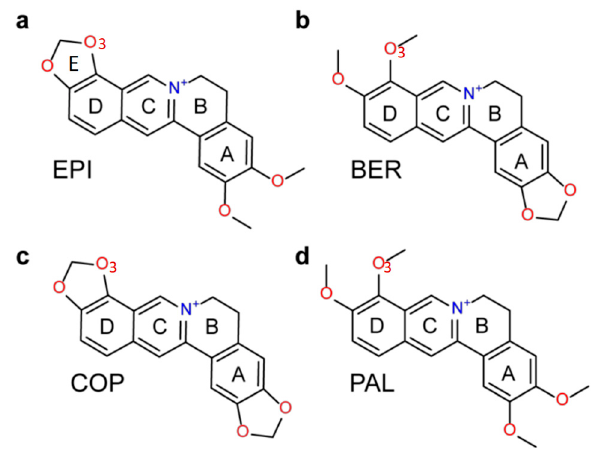
Figure 1. Chemical structures of protoberberine alkaloids: ( a ) epiberberine (EPI), ( b ) berberine (BER), ( c ) coptisine (COP) and ( d ) palmatine (PAL).